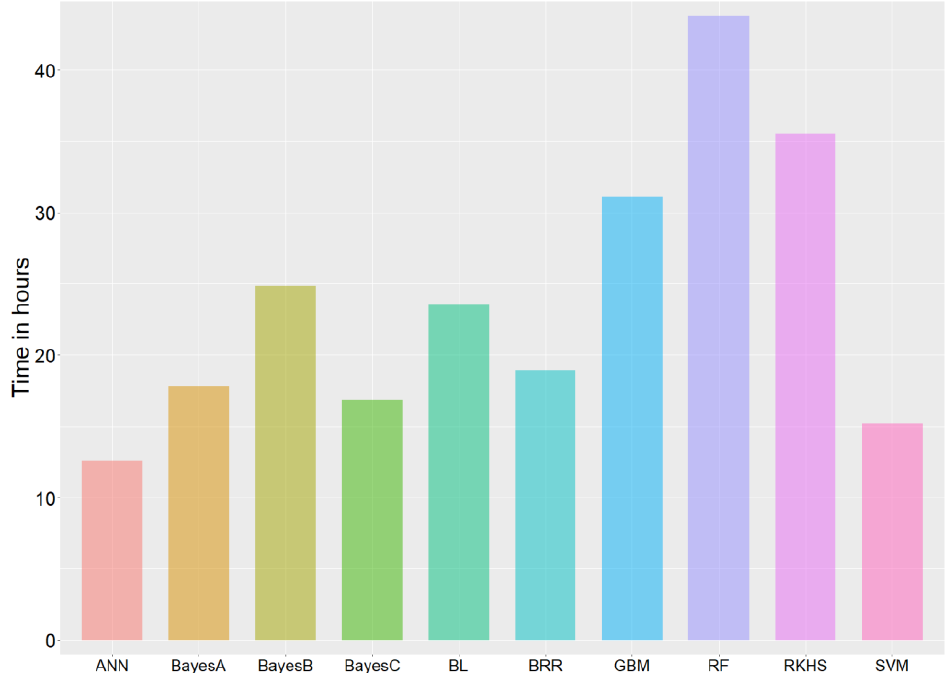
Figure 4. Comparison of the required computational time for fitting each of the ten algorithms. The O. mykiss survival trait dataset was used for this analysis.